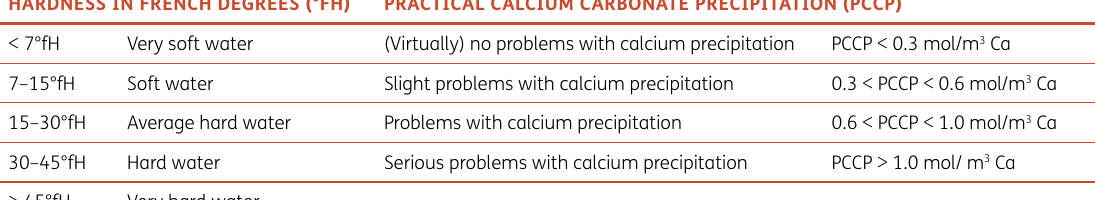
Table 1 Classification of hardness and